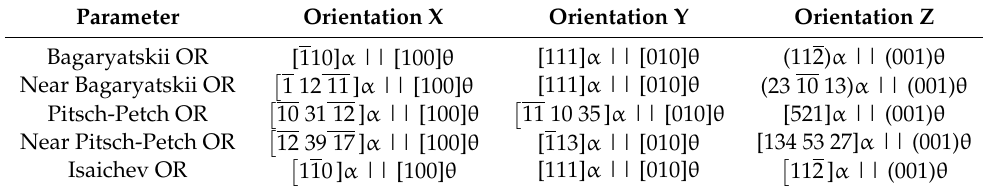
Table 2. Orientation of the various